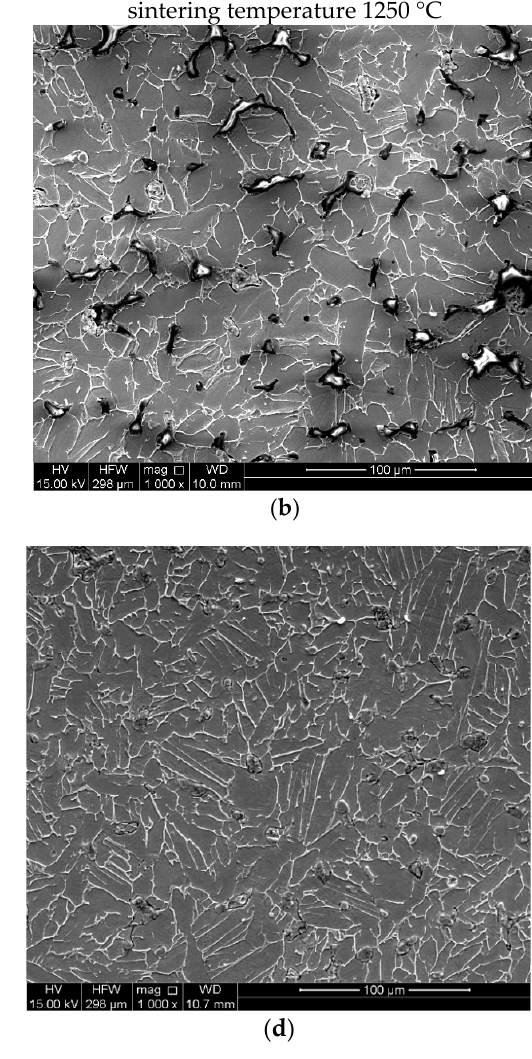
Figure 5. SEM images of PM samples sintered at 1100 °C: ( a ) compacted at 450 MPa and ( c ) 735 MPa, and PM samples sintered at 1250 °C: ( b ) compacted at pressure 450 MPa and ( d ) 735 MPa. Table 3. Porosity percentage of PM samples.